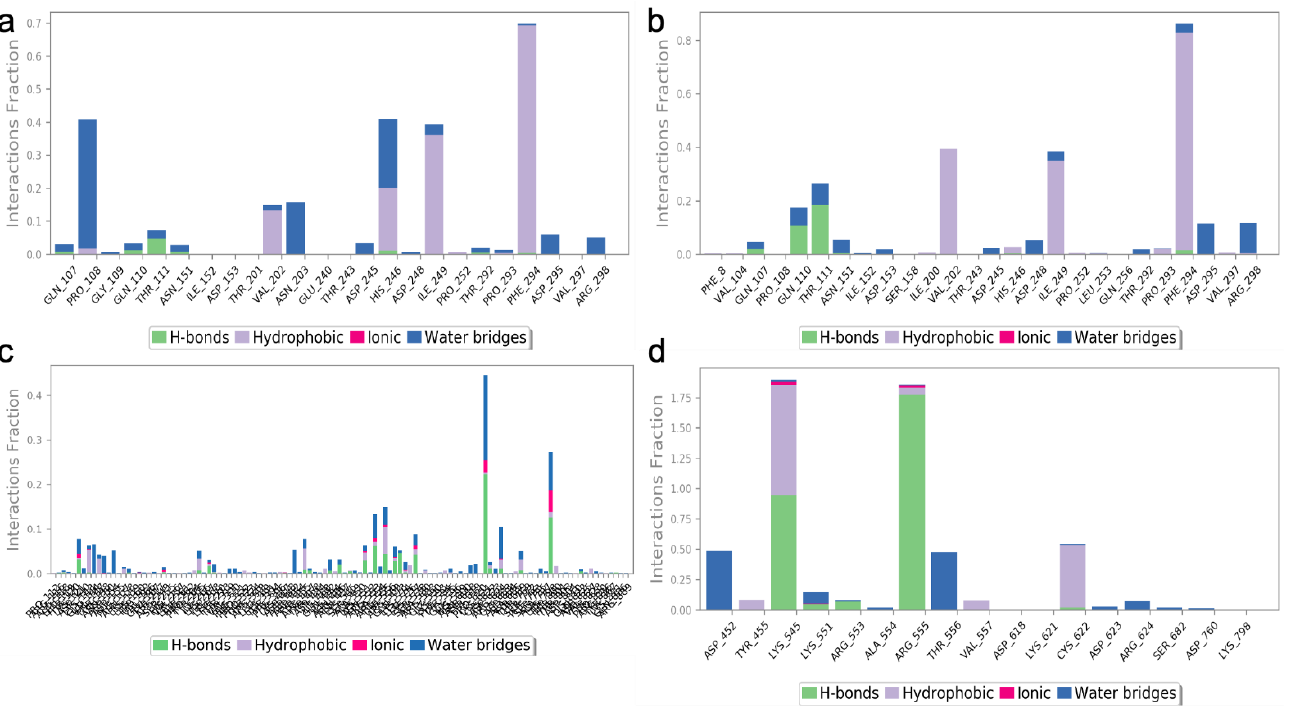
Figure 11. The protein – ligand contact of the two highest-ranked complex molecules of M pro [M1 ( a ), M2 ( b )] and RDRP [R1 ( c ), R2 ( d )]. The bar graph with the appropriate colors indicates the type of interaction, and the interaction fraction represents the percentage of interactions. The normal baseline of interactions used to illustrate potential interactions is 0.3, which stands for 30% of the interaction.